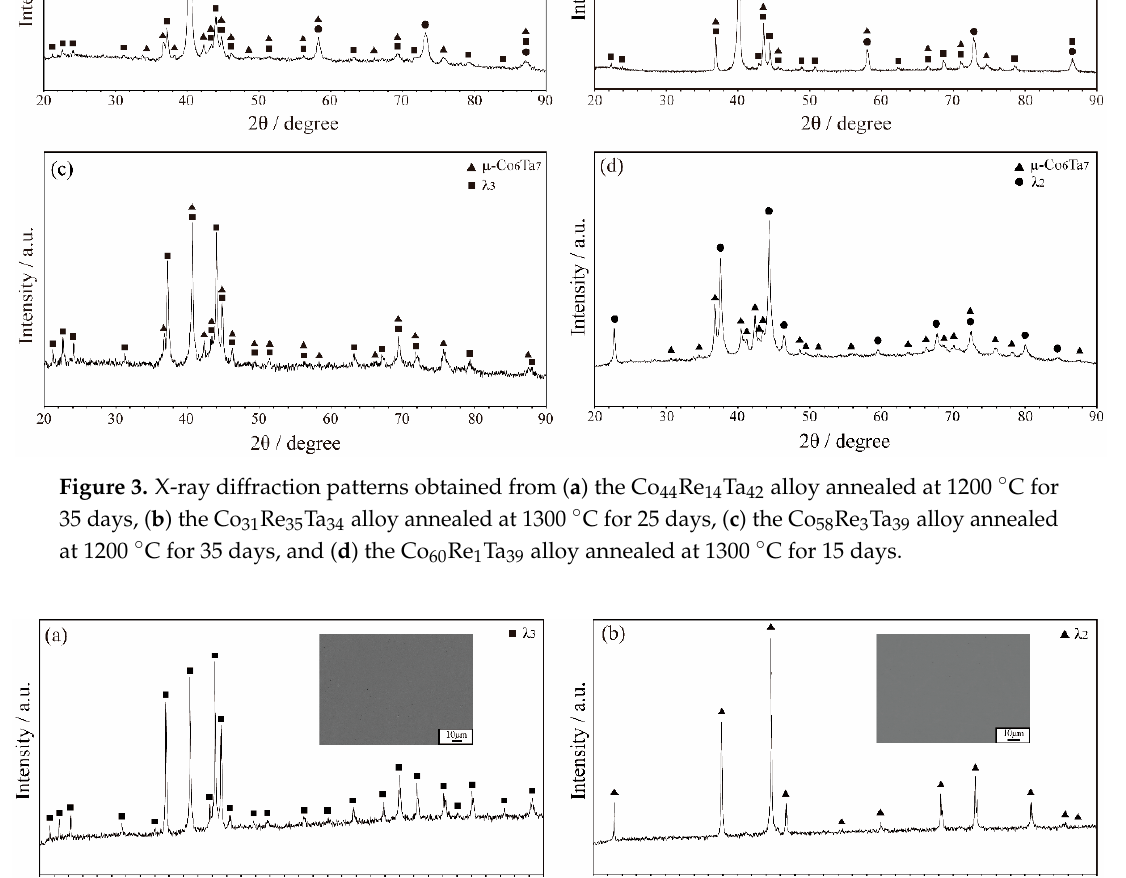
Figure 4. X-ray diffraction patterns obtained from ( a ) the Co 66 Re 5 Ta 29 alloy annealed at 1200 °C for 35 days and ( b ) the Co 68 Re 3 Ta 29 alloy annealed at 1300 °C for 15 days.